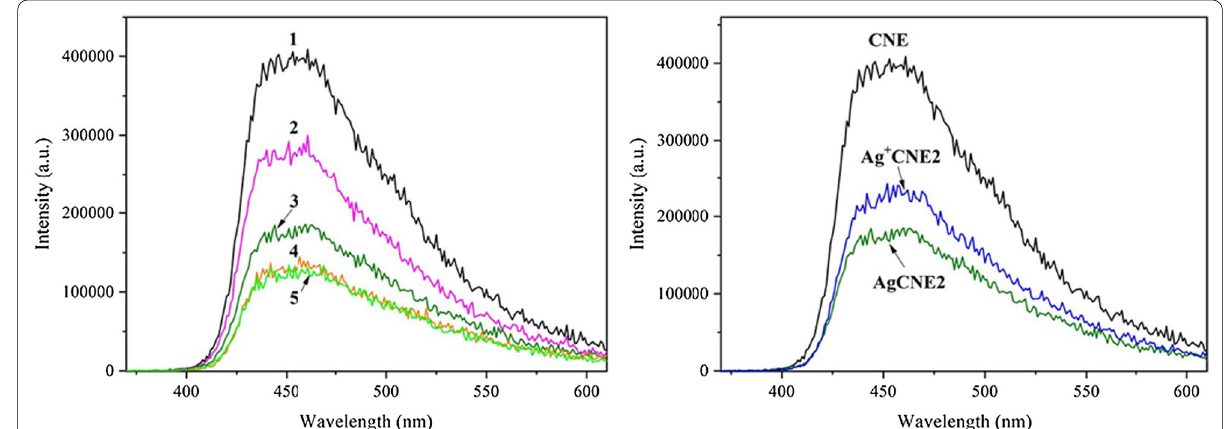
Fig. 12 Photoluminescence spectra of AgCNE nanomaterials. Left—(1) CNE, (2) AgCNE1, (3) AgCNE2, (4) AgCNE3, (5) AgCNE4. Right—CNE, Ag + CNE2 and